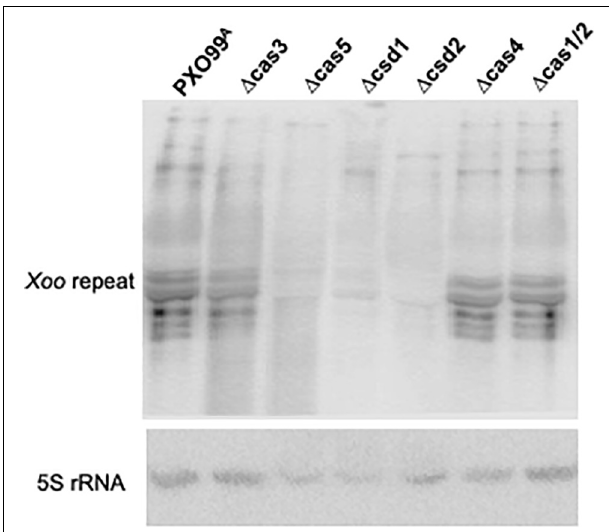
FIGURE 5 | Functions of Cas proteins of the Xoo CRISPR system in pre-crRNA processing and PAM-dependent DNA silencing. Northern blot analysis of total RNAs from PXO99 A and its derived Cas gene knockout strains for pre-crRNA processing. Total RNA was probed using labeled oligonucleotides of the repeat sequences. Total RNA was hybridized with the 5S rRNA probe as a loading control.